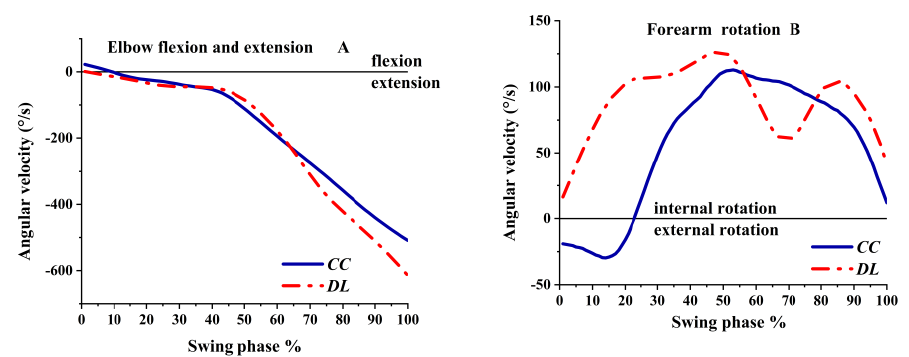
the swing phase, especially in DL, as shown in Figure 8B. The forearm was internal rotation angular velocity in DL during the whole swing phase, while the angular velocity varied from external rotation to internal rotation in CC. The extension angular velocity of the elbow was rapidly increased, as a faster extension angular velocity in CC was observed after 65%, as shown in Figure 8A.